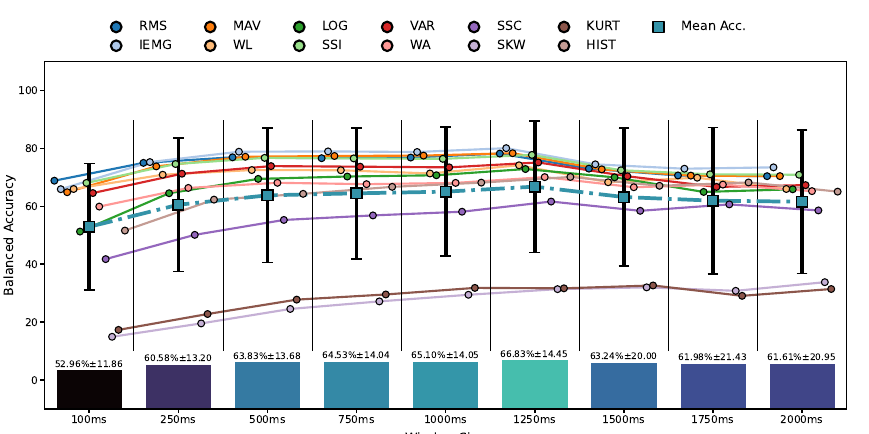
Figure 7. Features’ mean test accuracy for different window sizes of all classifiers using the sEMG data of Participants 4, 5, and 6.